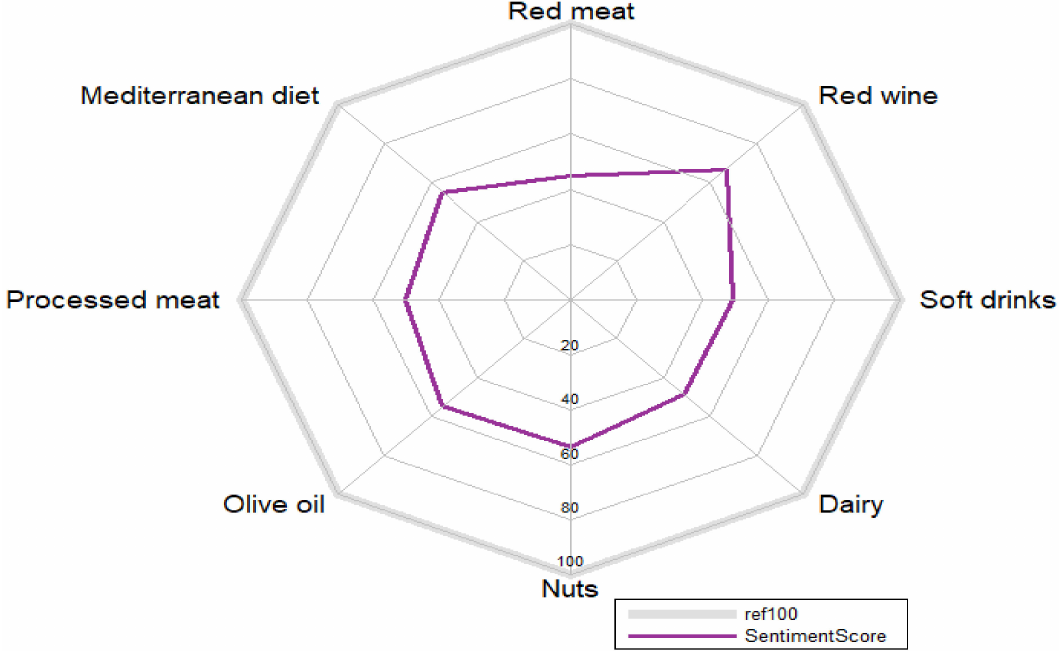
Figure 2. Sentiment analysis of each food group analyzed. The average score obtained by all the tweets posted with a certain hashtag determines the overall score of each food